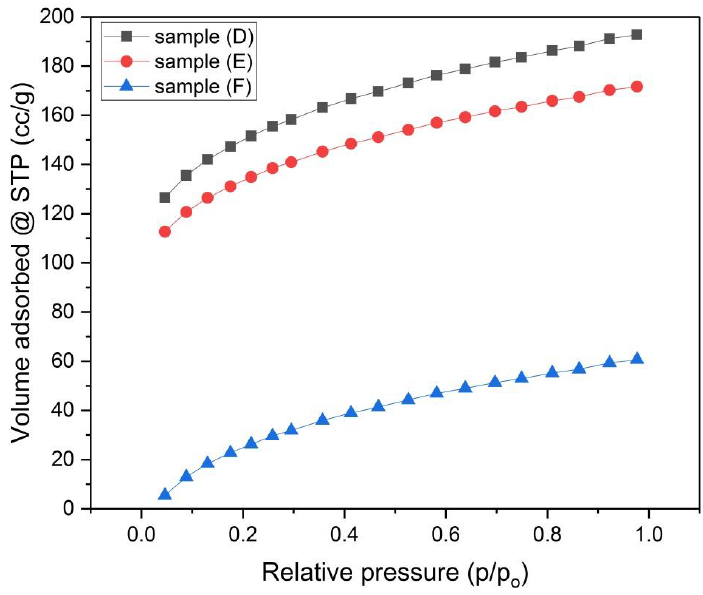
Figure 7. N 2 -Adsorption Isotherms for samples (D), (E) and (F).